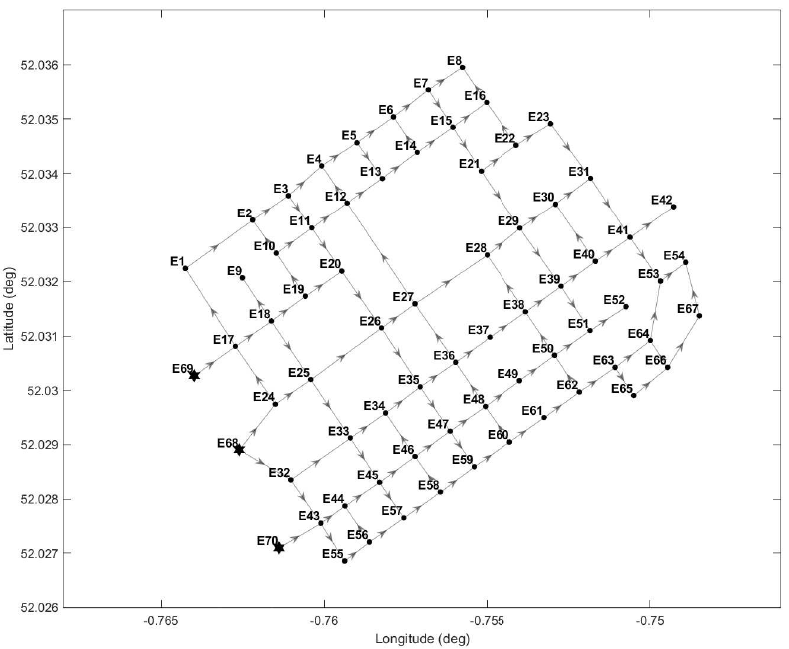
Figure 8. Eastbound at 15 m, 3 retail points (E68, E69, E70) and 67 service points (E1 ∼ E67) and 107 directed routes, (Oldbrook, Milton Keynes, United